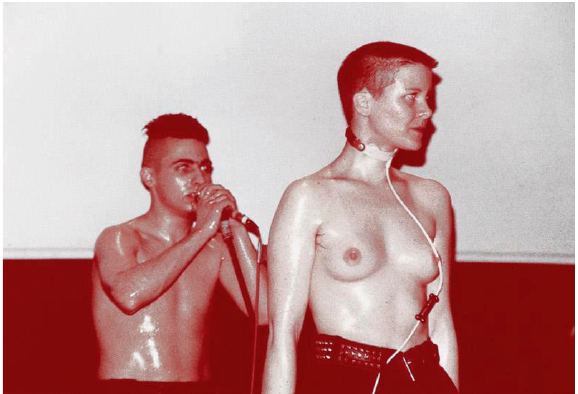
Figure 13. Le Syndicat, performance, “Divergences/Divisions” Festival, Bordeaux, March 1985.